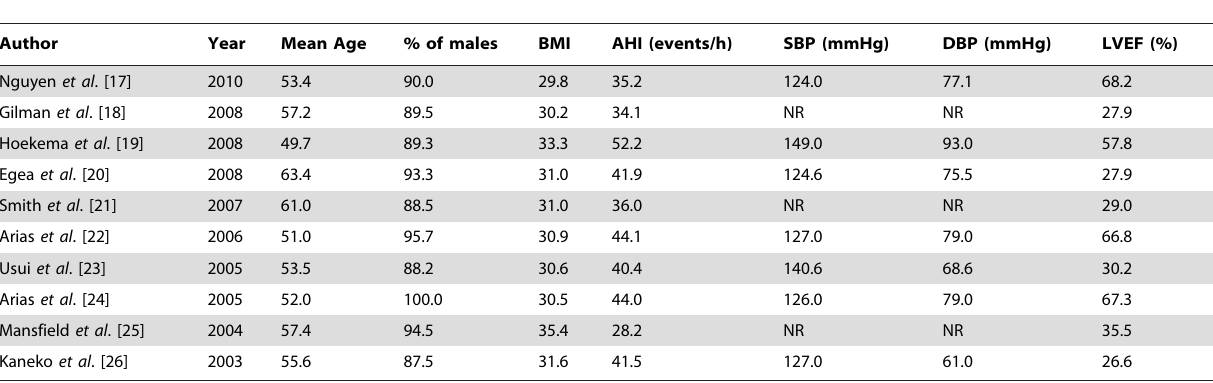
Table 2. The patient characteristics of the 10 included